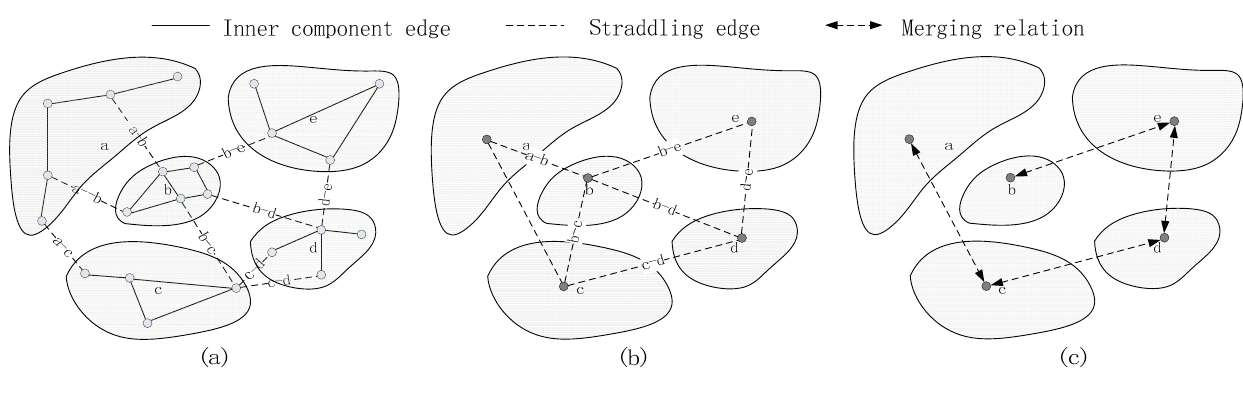
Figure 3. Merging of the SDDG (spatial data dependence graph) components. ( a ) The SDDG components with straddling edges; ( b ) Graph of the components with straddling edges; ( c ) The merging of the